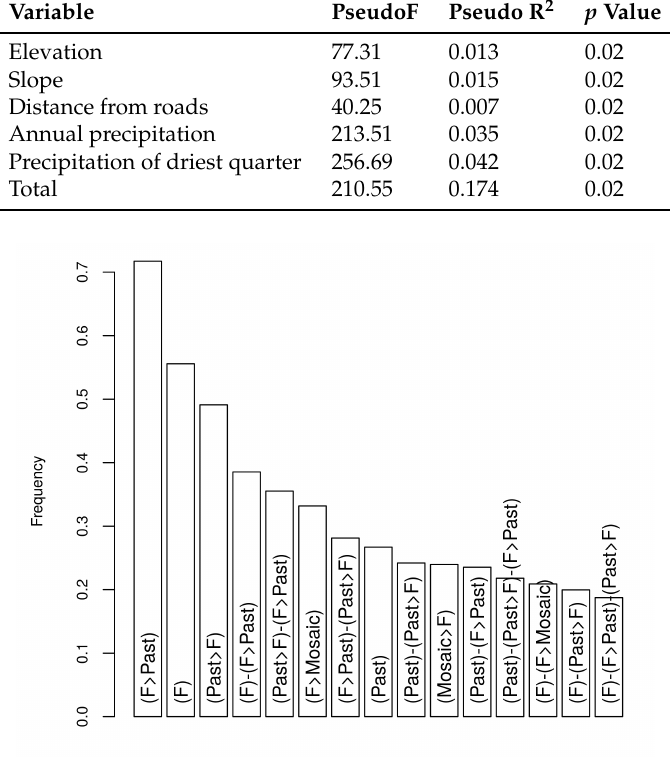
Figure 10. Most common